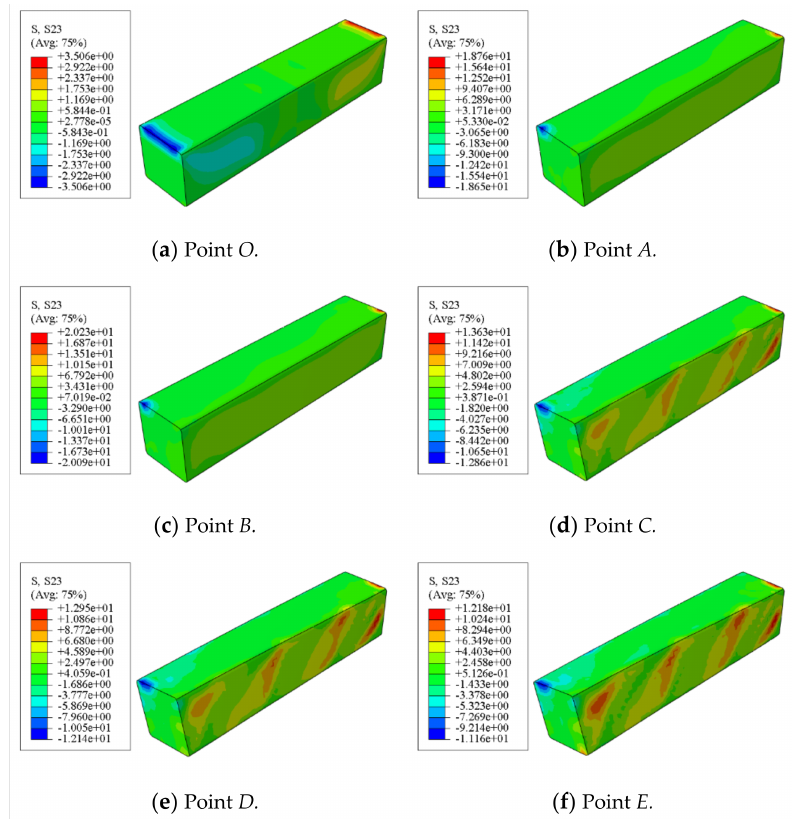
Figure 15. Shear stress distribution of concrete.